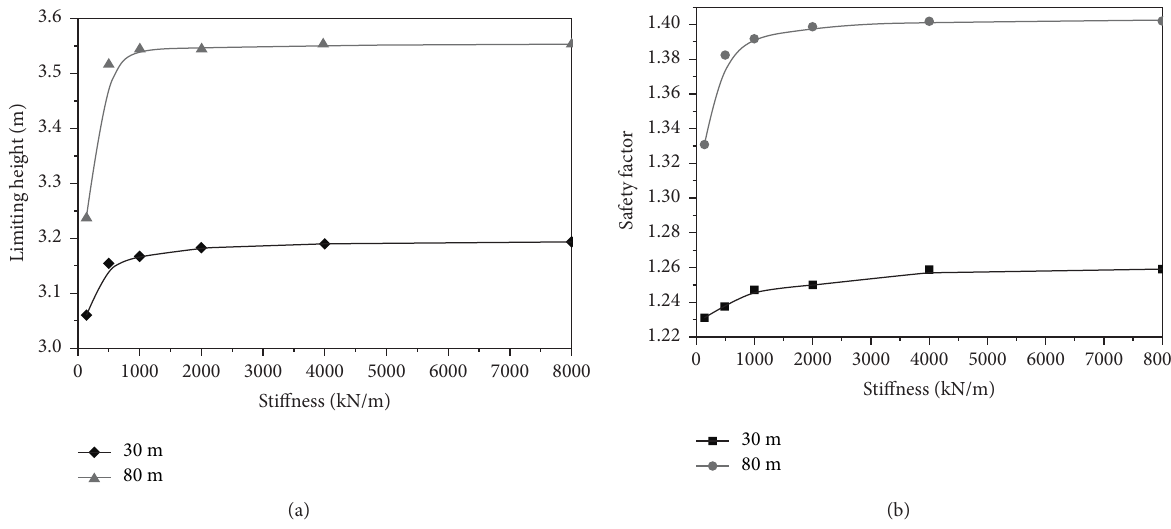
Figure 6: Effect of stiffness of geotextiles on limiting stack height of